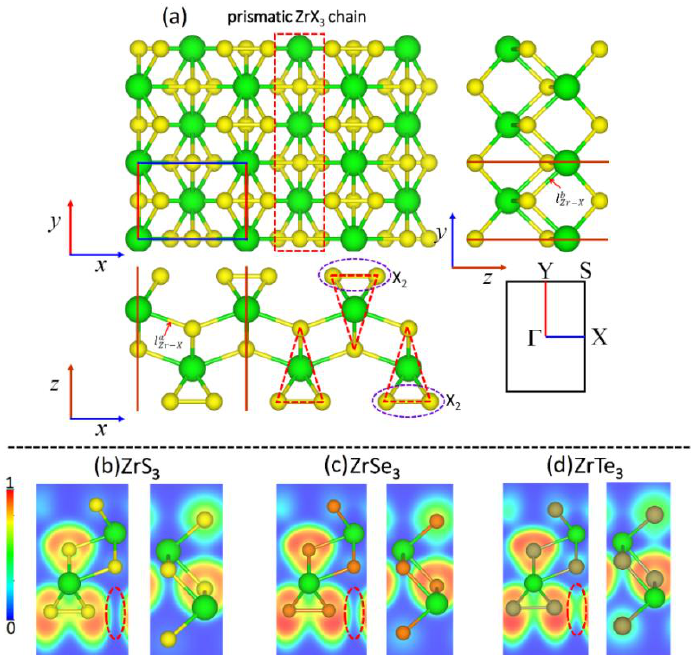
Figure 1. ( a ) Crystal structure of the ZrX 3 (X = S, Se, Te) monolayers. The primitive cell, first Brillouin zone, a prismatic chain of ZrX 3 (red dashed-line rectangle), surface X 2 moieties, and Zr-X bonds in zx and zy planes ( 𝑙 𝑍𝑟−𝑋𝑎 , 𝑙 𝑍𝑟−𝑋𝑏 ) are also distinguished. ( b – d ) Contour maps of electron localization function (ELF) for the ZrX 3 monolayers. The regions in between surface X 2 moieties are shown by red dashed-line ellipses. In this figure, green, yellow, orange, and dark yellow circles indicate Zr, S, Se, and Te atoms, respectively.